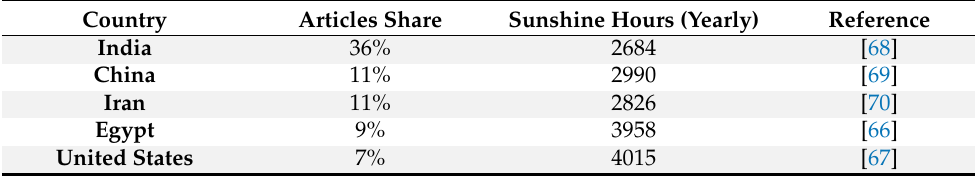
Table 4. Country-wise distribution of article share having maximum yearly sunshine